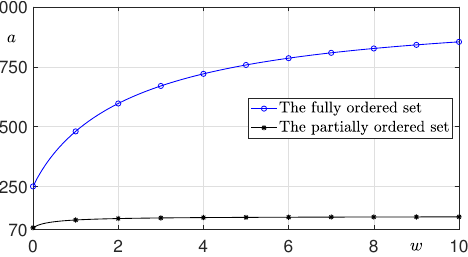
Figure 9. In the case of Figure 8, reward a for w = [ 0,10 ] with U C = 1000. When w = 0, it implies policy P2. In both chains, when w increases, a converges to a constant